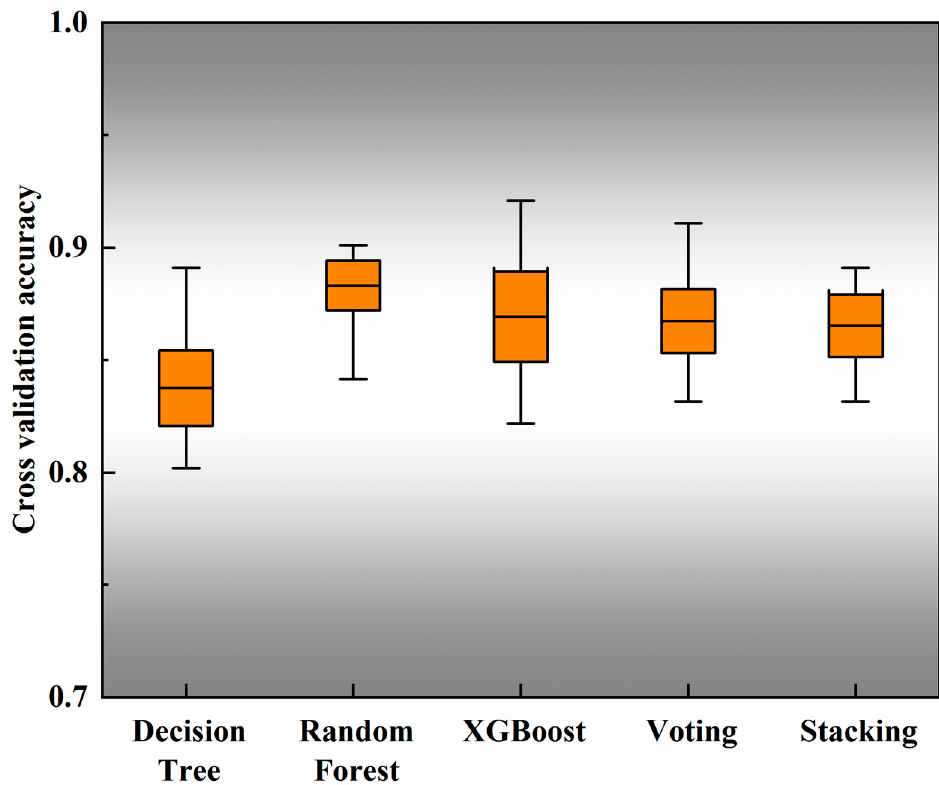
Figure 5. Box plots of mean CV accuracies for five models. (The black line in the middle of the box plots indicates the mean CV accuracy of each model, and the upper and lower limits denote the maximum and minimum CV accuracies).